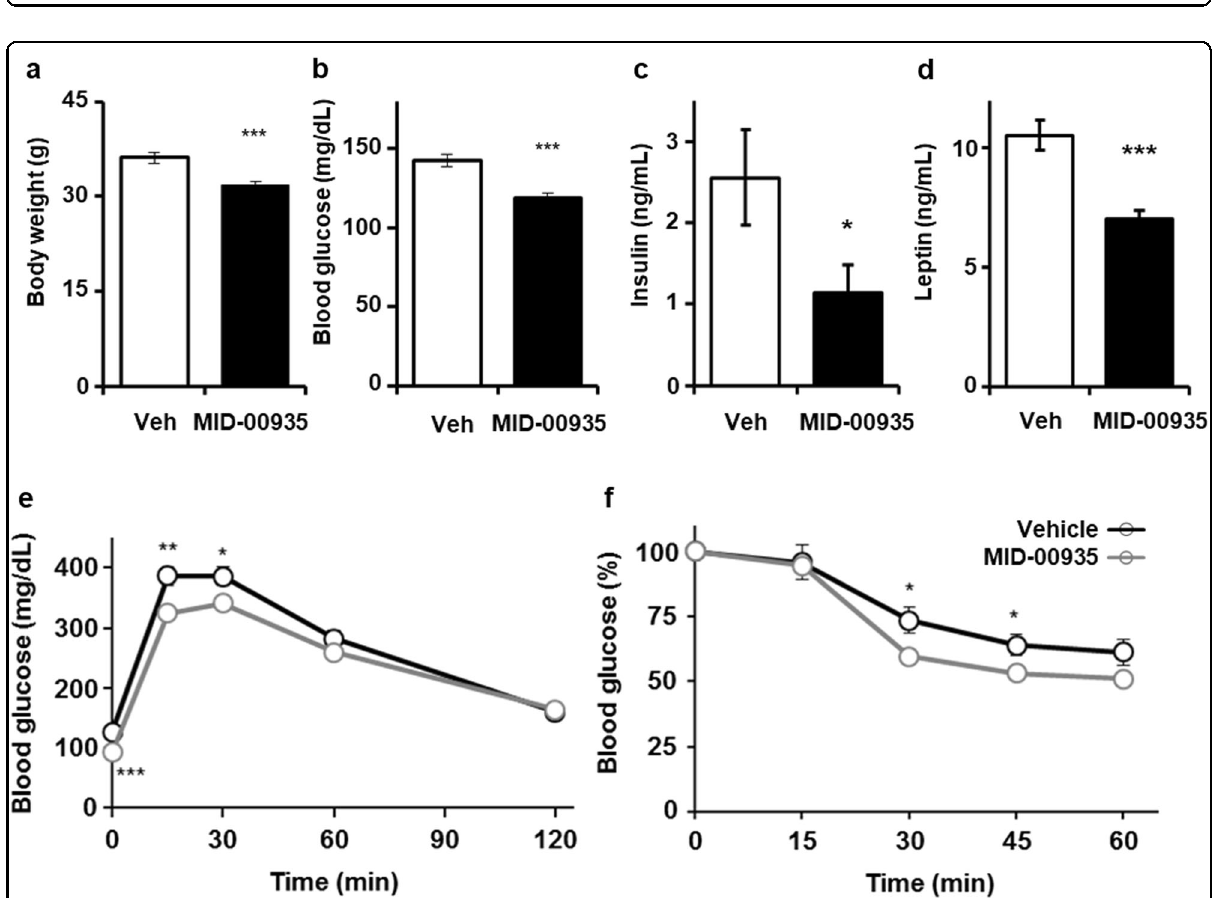
Fig. 4 MID-00935 treatment ameliorates insulin resistance in DIO mice. Four-week-old male mice were fed a high-fat diet for 8 weeks and orally treated with vehicle or MID-00935 (100 mpk, twice a day) for one week. Body weights and fasting blood glucose levels were measured ( a , b ). Serum was obtained from overnight-fasted mice. Serum insulin and leptin concentrations were determined ( n = 12 for each group) ( c , d ). Four-week-old male mice were fed a high-fat diet for 10 weeks and orally treated with vehicle or MID-00935 (100 mpk, twice a day) for one week. Glucose tolerance tests were performed in DIO mice after 1 week of MID-00935 treatment, and insulin tolerance tests were performed in DIO mice after 2 weeks of MID- 00935 treatment ( n = 10 for each group) ( e , f ). Data are presented as the means ± SEM. t -test; * p < 0.05, ** p < 0.01, *** p <